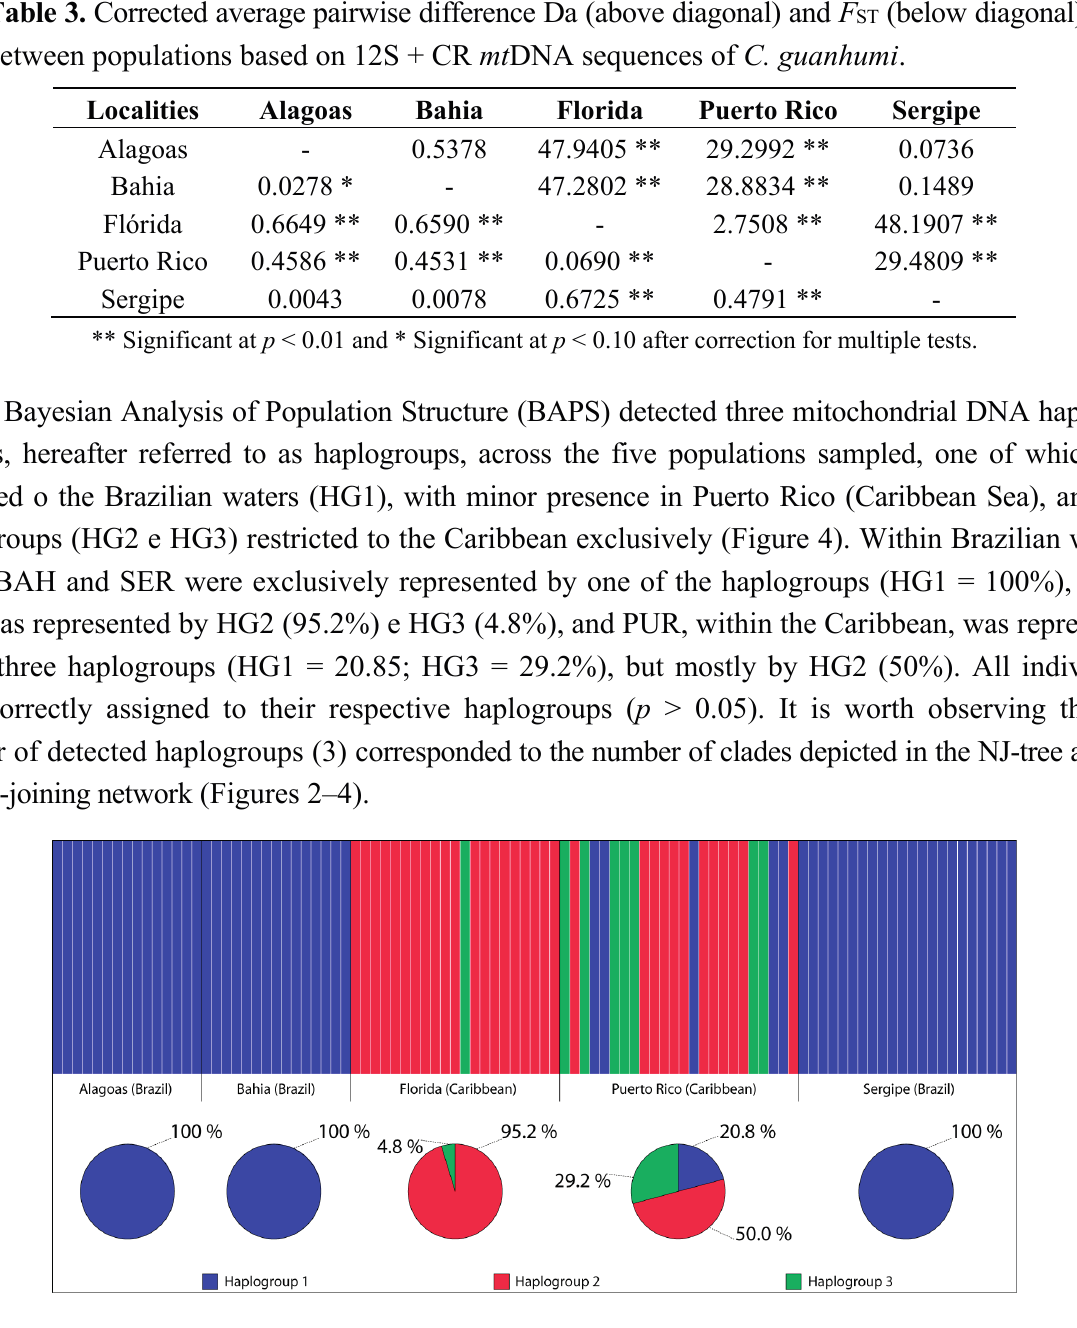
Table 2. Analysis of molecular variation (AMOVA) of C. guanhumi mt DNA sequences. Source of Variation df Sum of Squares Variance Components Percentage of Variation Φ ST ( p -value) Among populations 4 1097.095 13.529 Va 48.74 0.488 ( p = 0.00) Within populations 92